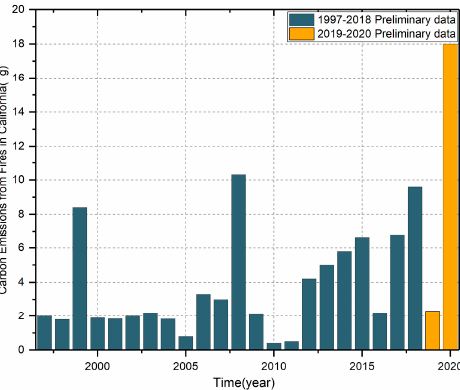
Figure 2. California wildfire carbon emissions from 1997 to 2020 (from NASA Earth).